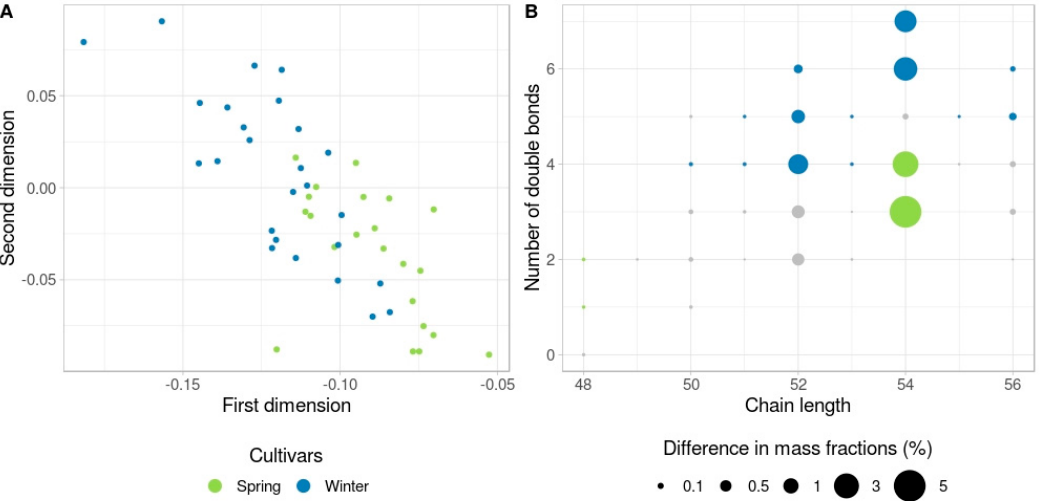
Figure 4. TAG comparison between winter and spring rapeseed. ( A ) Multidimensional scaling (MDS) plot of rapeseed samples (one minus Spearman correlation coefficient was used as the distance, two dimensions) demonstrating a clear segregation of winter and spring rapeseed samples. ( B ) The difference in the TAG mass fractions between winter and spring rapeseed. Color indicates which cultivar possesses a higher amount of certain TAG. Circle size represents the absolute difference in mass fractions. Grey circles correspond to the TAGs that do not show statistically significant differences.